Question: Looking at the figure, what chart type is it?
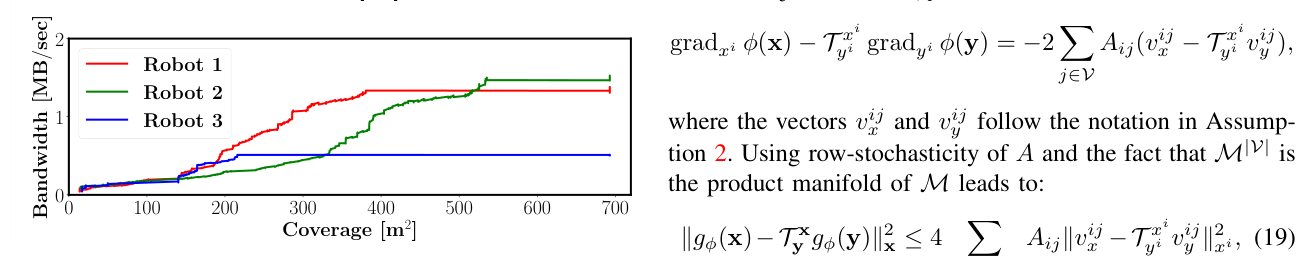
Answer: line